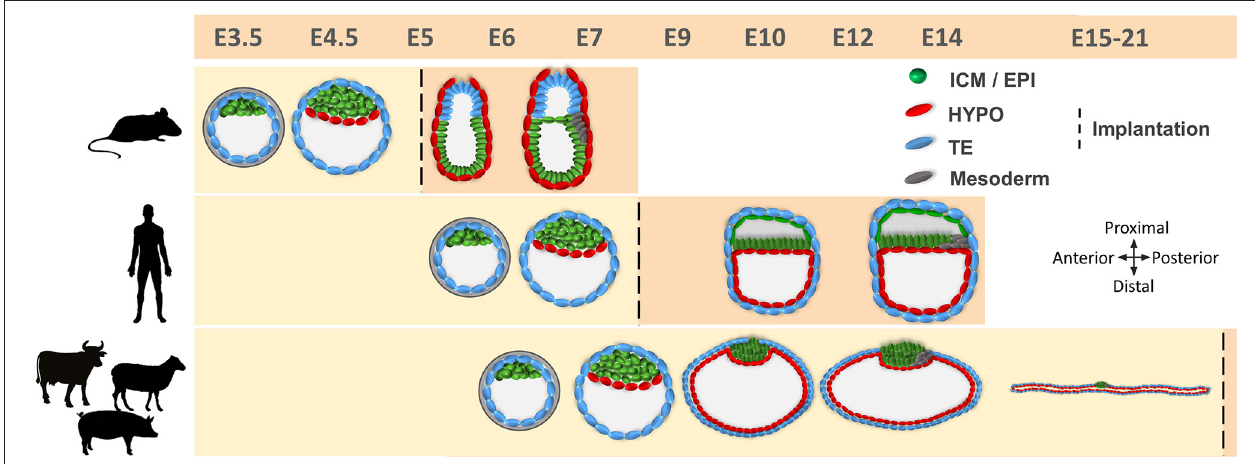
FIGURE 1 | Comparative developmental timeline between mice, humans, and farm ungulates. Different cell lineages are indicated. Embryo development in humans and farm ungulates is delayed compared to mice. Implantation takes place after blastocyst hatching in mice and humans, while in farm ungulates it occurs following conceptus elongation. Mouse epiblast develops in a cup shape after the blastocyst stage, while in humans and farm ungulates it forms a flat embryonic disc. E, embryonic day; ICM, inner cell mass; EPI, epiblast; HYPO, hypoblast; TE,